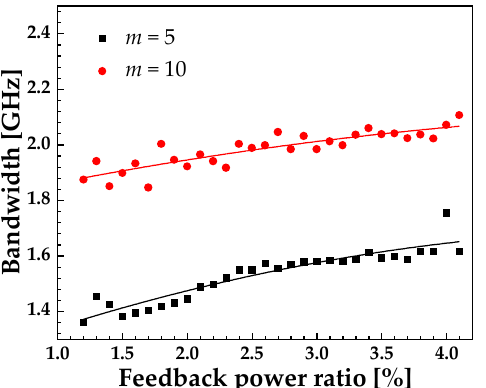
Figure 9. Bandwidth of chaos vs. feedback power ratio under I = 1.1 I th , τ f = 2.4 ns, m = 5 (black squares) and m = 10 (red circles).